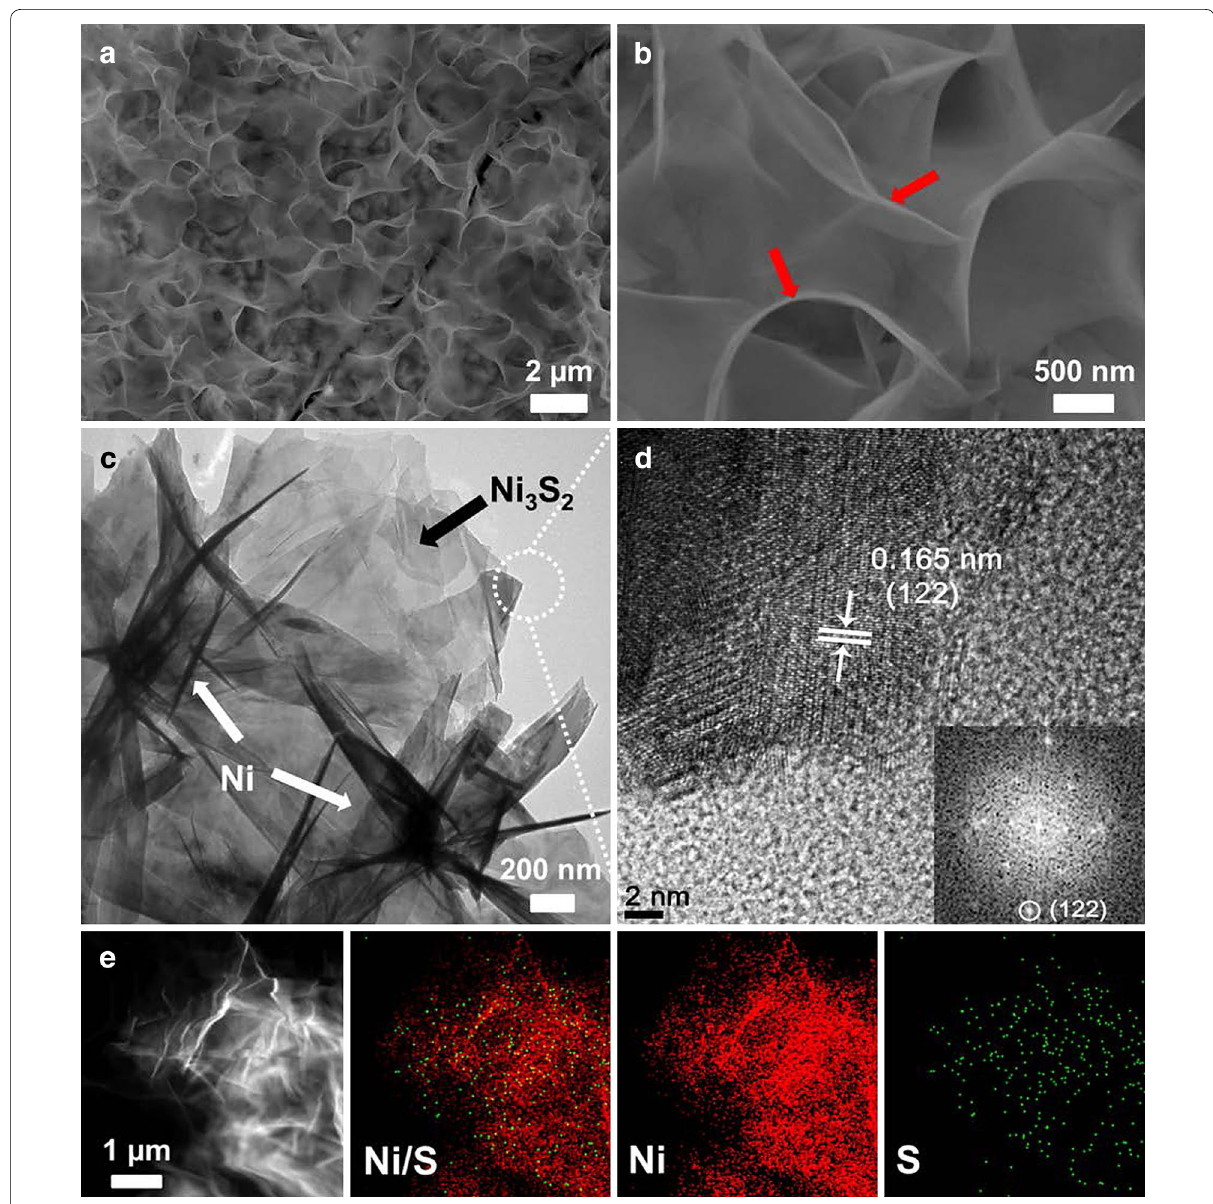
Fig. 2 a , b FE-SEM images of SW Ni–Ni 3 S 2 /NF, c TEM image, d HR-TEM image, and e corresponding EDS elemental mapping of nickel nanosheets scrapped down from the Ni foam. The arrows in b show the upright edges and existence of spider on web-like Ni